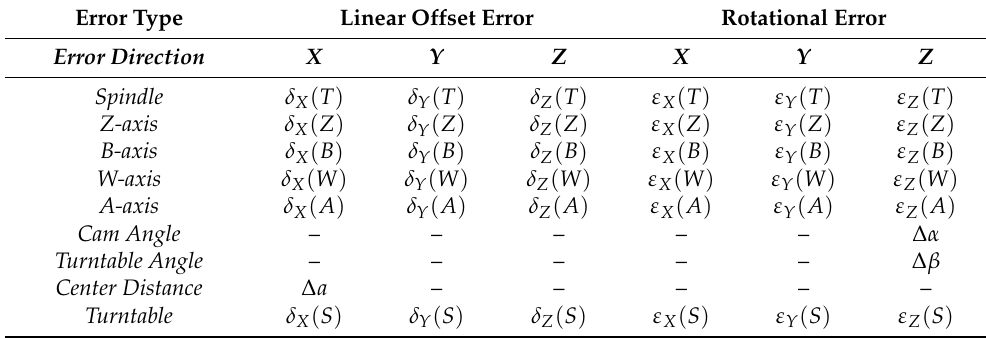
Table 1. Errors of the special machine tool.